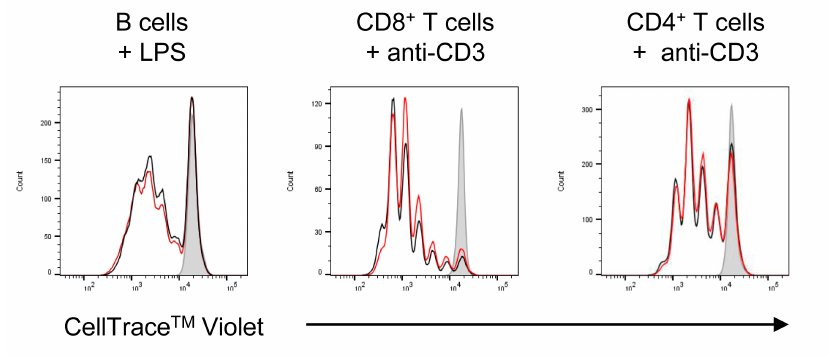
Figure 4. Effects of NanoMBGs on the proliferation of different subpopulations of spleen cells. Spleen cells were cultured for 72 h in the presence of different stimuli (LPS or anti ‐ CD3 Ab); CellTrace TM Violet was used to assess the proliferation capacity of each subpopulation. The effect of different stimuli in the presence (red line) or absence (black line) of FITC ‐ NanoMBGs was analyzed. Grey: unstimulated control. Results of one representative experiment out of three performed are shown here .